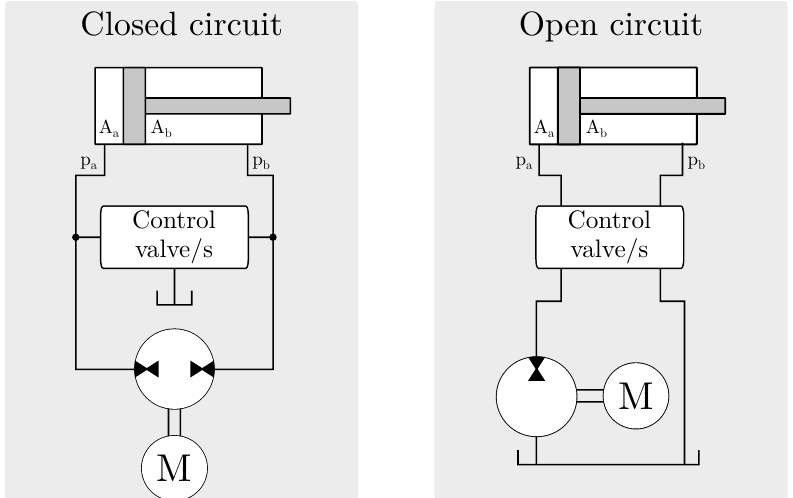
Figure 1. Generalised system architectures. Pilot-operated check valves or shuttle valves are often used in closed circuits. In open circuits, solutions with directional valves or multiple on/off valves can be